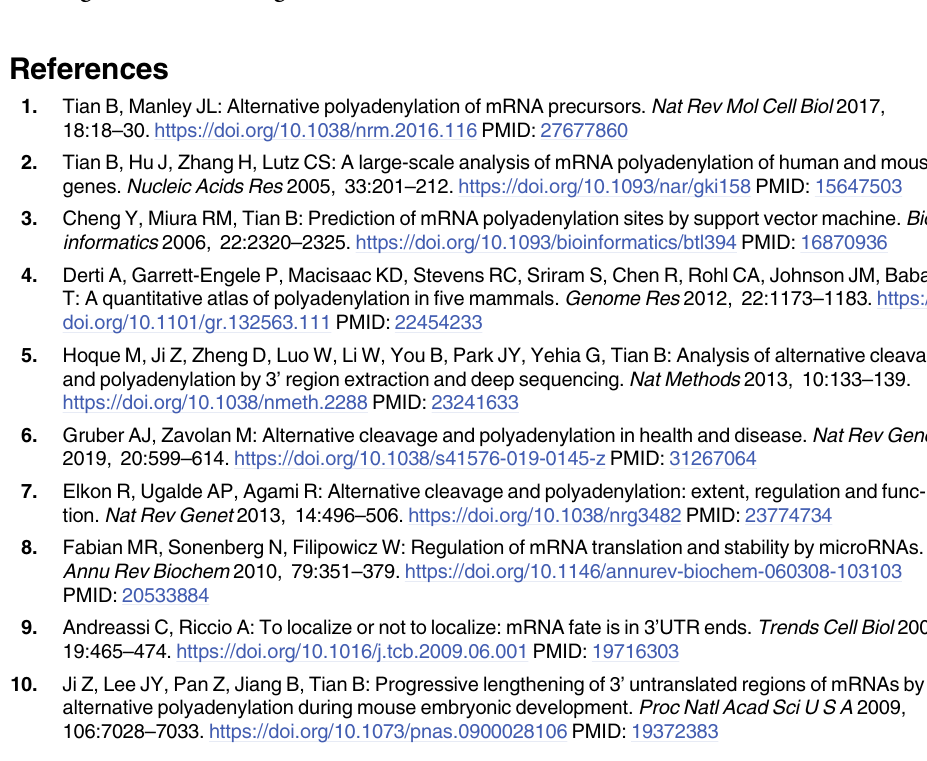
S6 Table. GUGU-interfering variants and their association with